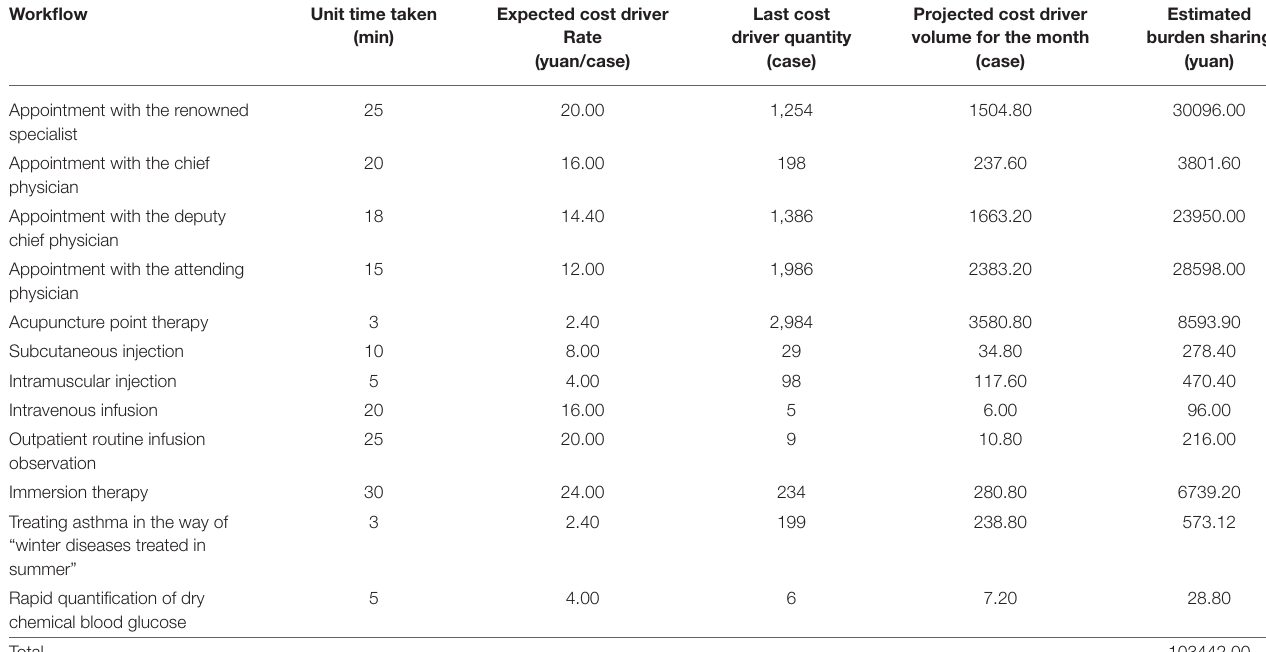
TABLE 2 | Costs budget for traditional Chinese medicine departments.